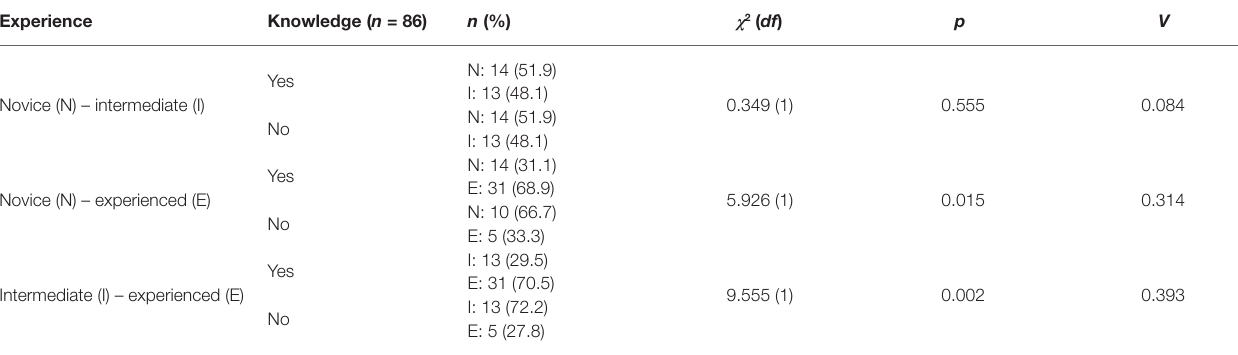
TABLE 3 | Frequency, percentage, and statistical analysis according to the “knowledge” item.